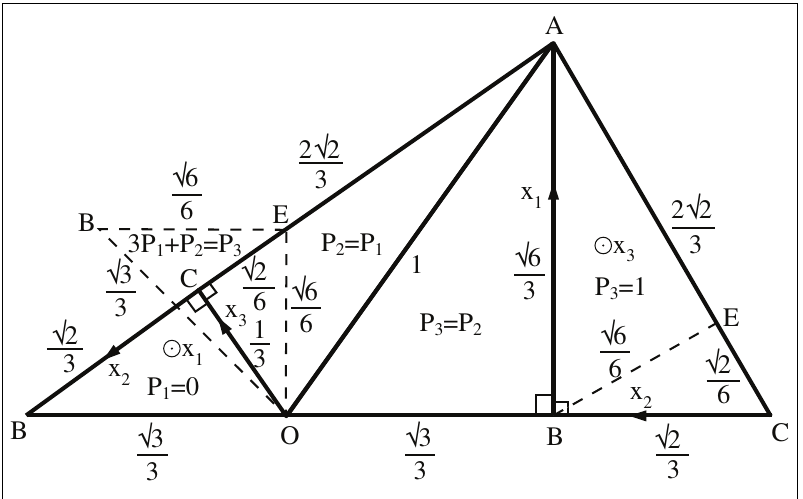
Figure 2. The net of the principal barycentric tetrahedron OABC for ordered eigenvalues, viewed from the outside. A perfect depolarizer is represented by point O and a pure system by point A . All the faces are right-angled triangles. Triangles ABO and BCO are similar. The basis vectors x and the lengths of the edges are shown. Sixteen of these tetrahedra combine to give the regular tetradron ( A , A ) for unordered eigenvalues and 72 to give the original cube defined by the Stokes 1 , A 2 , A 3 condition. The tetrahedron OABE corresponds to nonnegative g 3 , with g 3 = 0 on the plane OBE